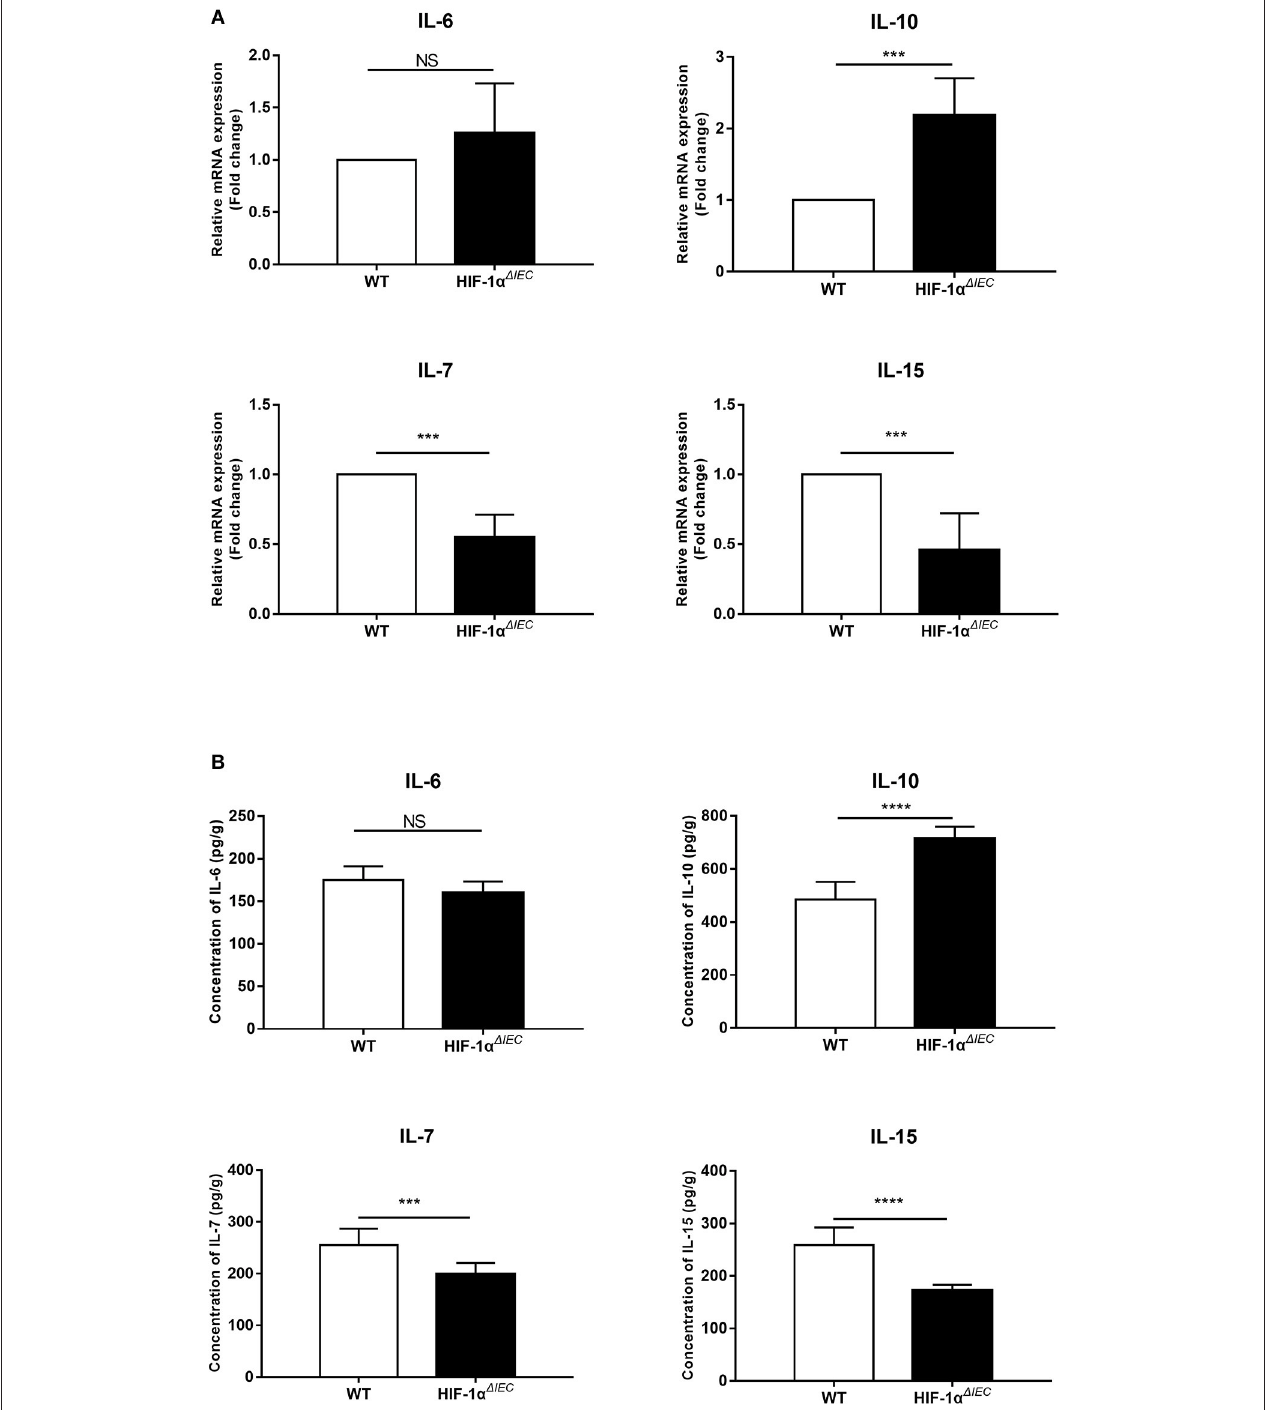
FIGURE 1 | Hif1- α signaling modulates the intestinal epithelial cells (IECs) cytokines expression. mRNA (A) and protein (B) expression of IL-6, IL-10, IL-17, and IL-15 were examined in small intestinal epithelium samples from WT or Hif1- α ∆ IEC mice ( n = 5–8 mice/group). *** P < 0.001; **** P < 0.0001; NS, not significant.